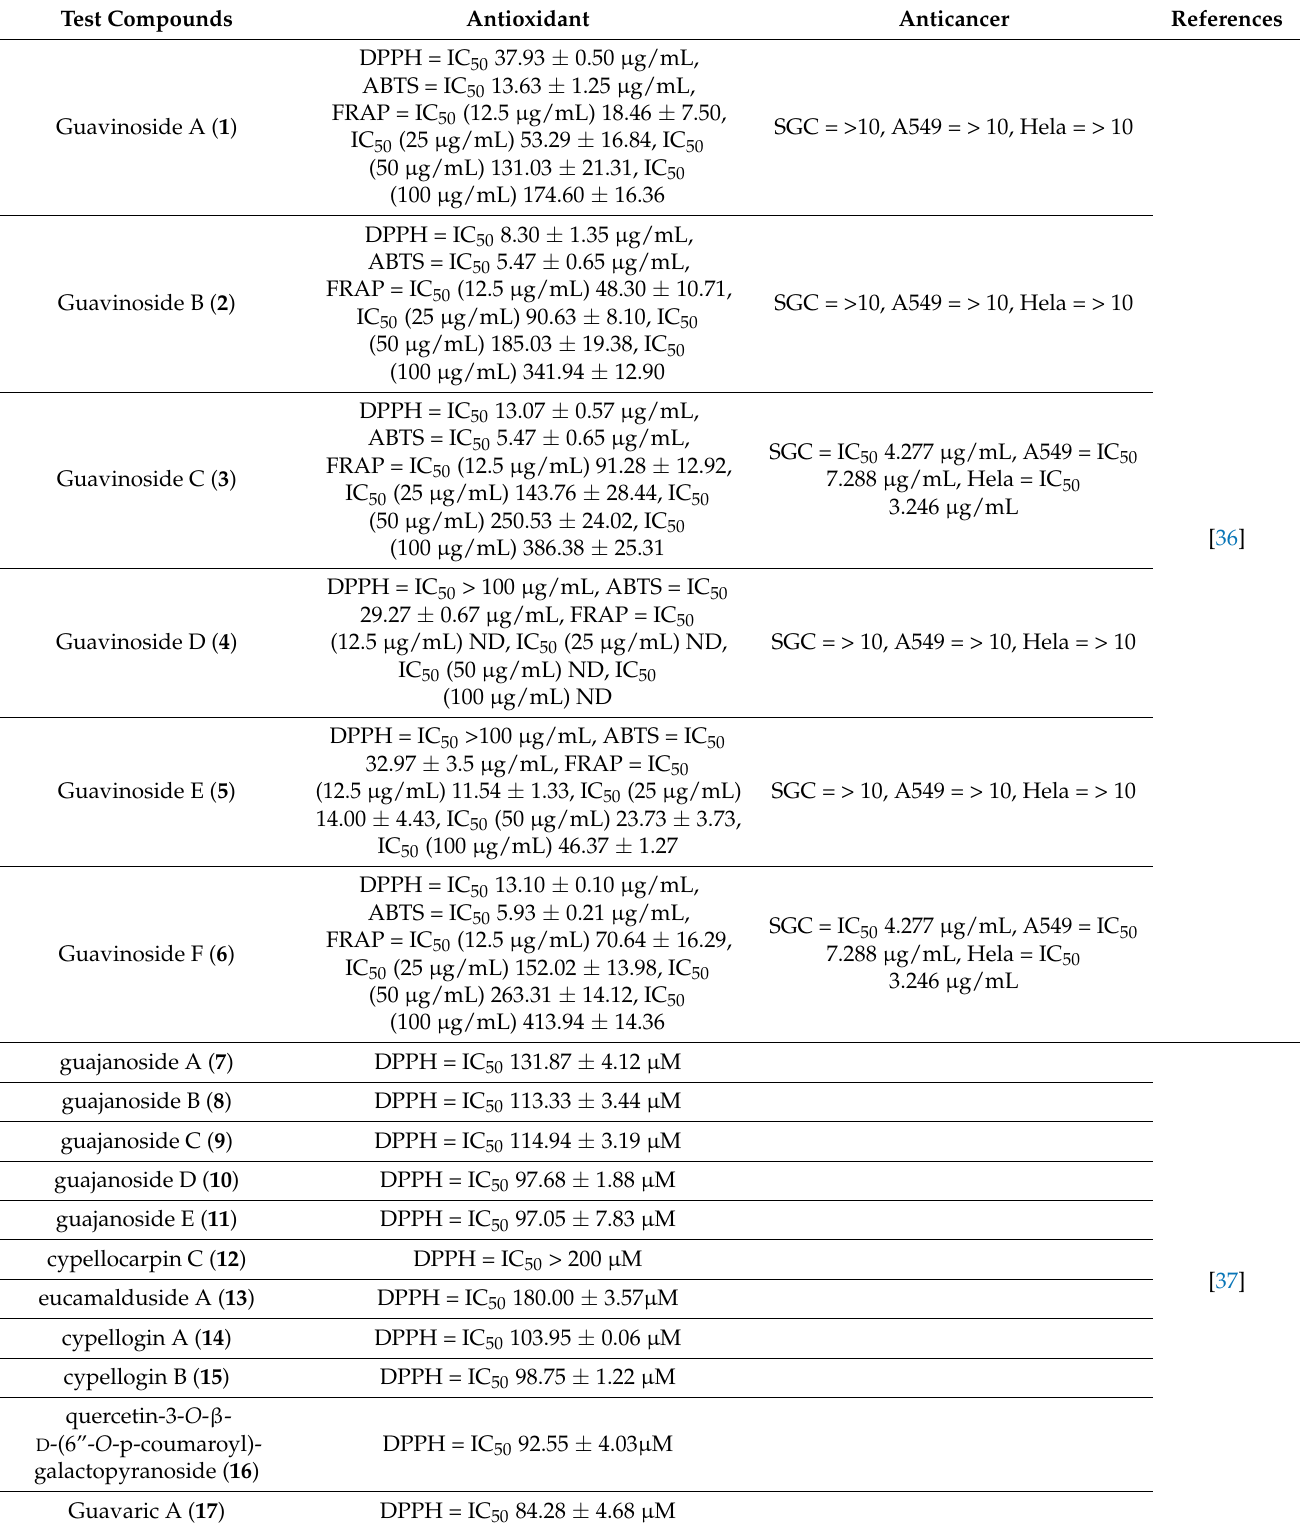
Table 5. Antioxidant and anticancer activities of isolated compounds from P. guajava